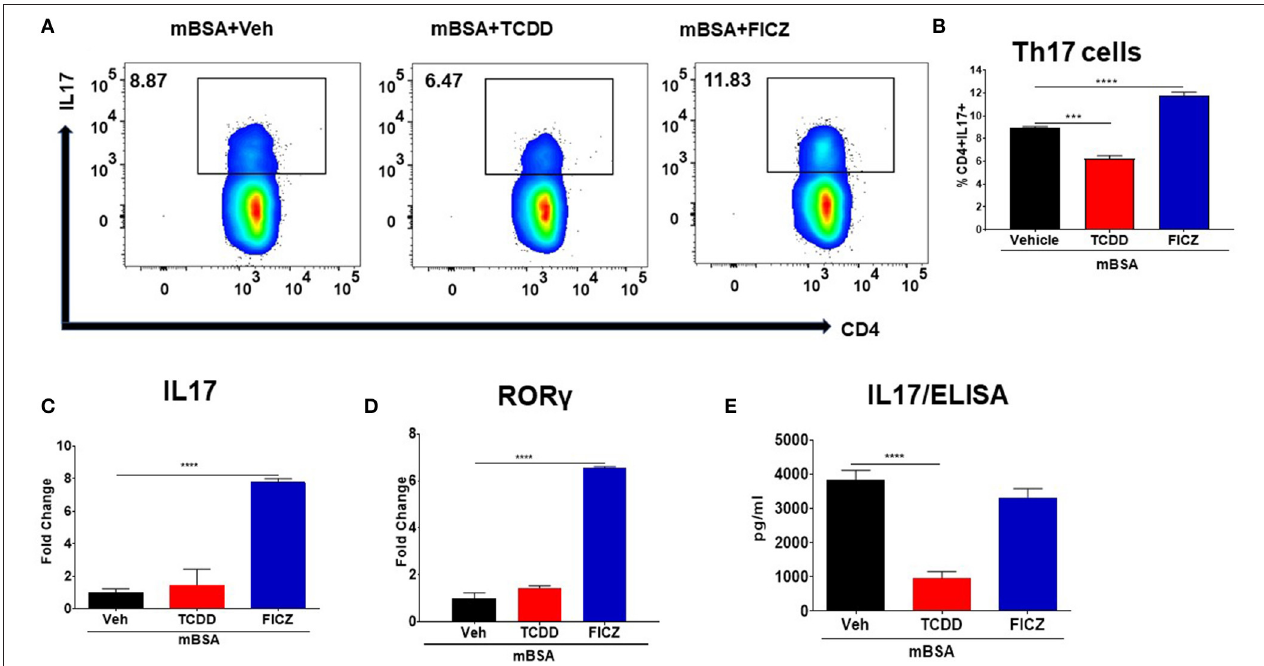
FIGURE 5 | Effect of TCDD and FICZ on Th-17 cells during DTH response. DTH was induced as described in Figure 1 legend and DLNs were analyzed for Th-17 cells. (A) Representative plots from FlowJo software analysis of flow cytometry data showing CD4 + IL7 + cells. (B) Percentage of CD4 + IL17 + cells based on groups of 5 mice. (C) qRT-PCR validation of mRNA expression of IL17 in DLN cells. (D) qRT-PCR validation of mRNA expression of ROR γ in DLN cells. (E) DLN cells were plated overnight in a complete medium and culture supernatants were harvested and subjected to ELISA for IL17. Vertical bars represent Mean ± SEM and significant differences between groups are shown with asterisks (*** p < 0.001, **** p < 0.0001) based on one-way